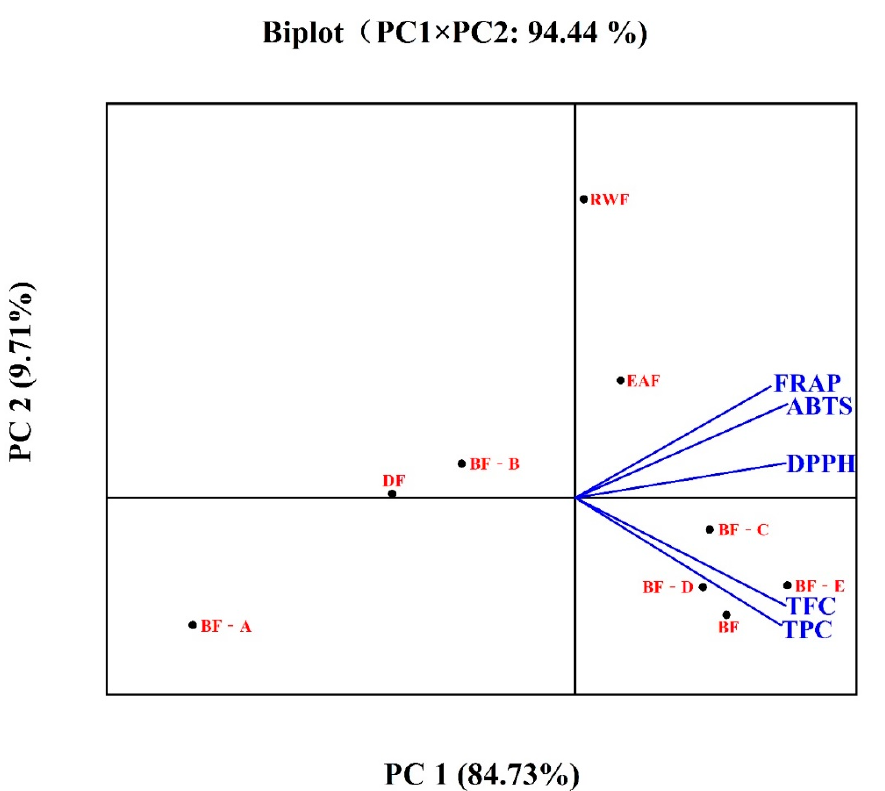
Figure 2. PCA analysis on total phenolics, flavonoids, and antioxidant activity. Means with different letters indicate significant differences ( p < 0.05). DF, EAF, BF, RWF mean dichloromethane fraction, ethyl acetate fraction, n -butanol fraction, and residual water fraction. BF-A to E means BF was subjected to D101 column chromatography to yield five subfractions.